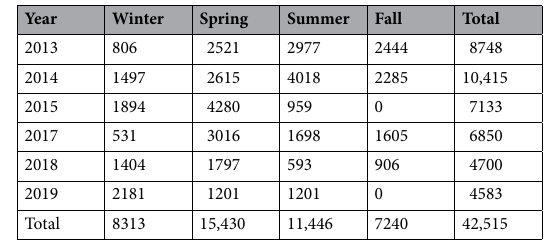
Table 1. Broad-scale aerial survey effort (km) in Southern New England shelf waters.